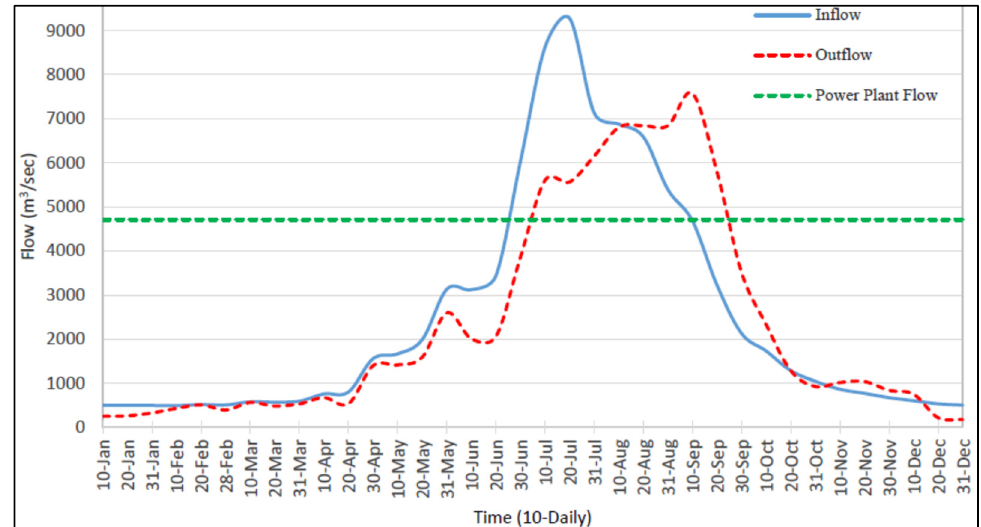
Figure 33. Inflow-Outflow Hydrographs of Application year 2025.